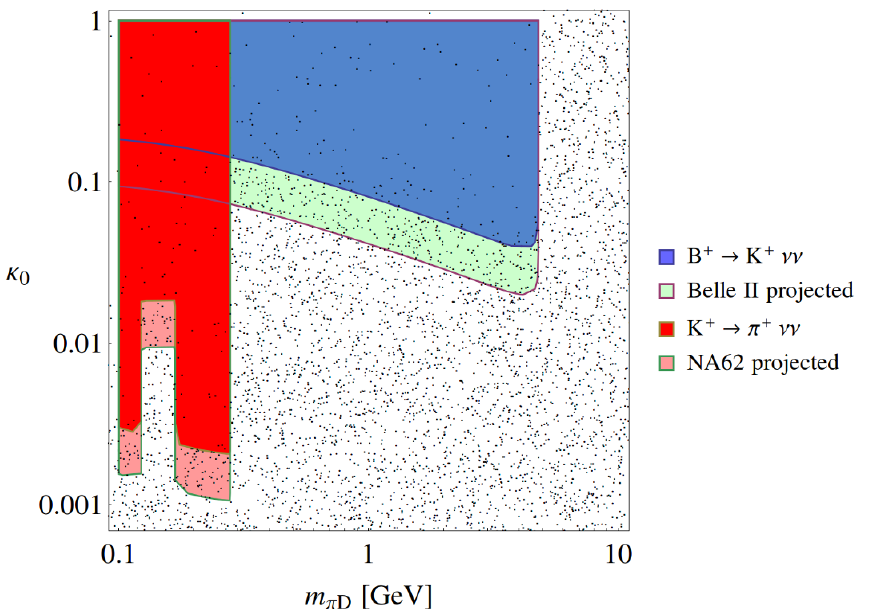
Figure 15. A scatter plot of points in the m (cid:25) D (cid:0) (cid:20) 0 plane that are allowed by meson mixing and meson decay constraints (black points). The points are generated by varying the parameters of (cid:20) as described in the text. The coloured regions are current and future constraints from meson decay measurements, in the case where (cid:20) = (cid:20) 0 1